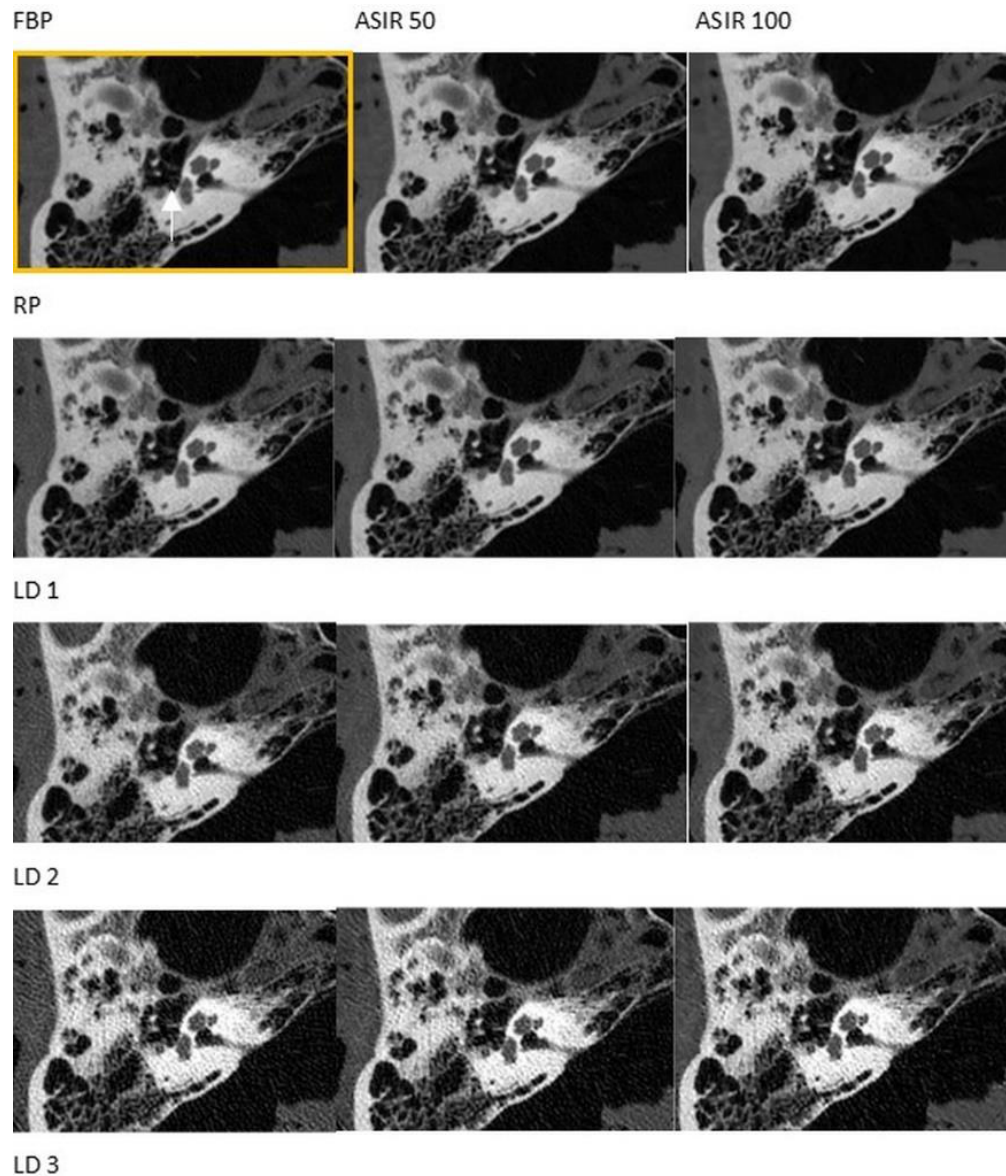
Figure 2. Visualization of the stapes (white arrow). RP = reference protocol (83.72 mGy), LD1 = low dose 1 protocol (26.79 mGy), LD2 = low dose 2 protocol (7.66 mGy), LD3 = low dose 3 protocol (4.82 mGy). Yellow box = Reference image using reference protocol and filtered back projection